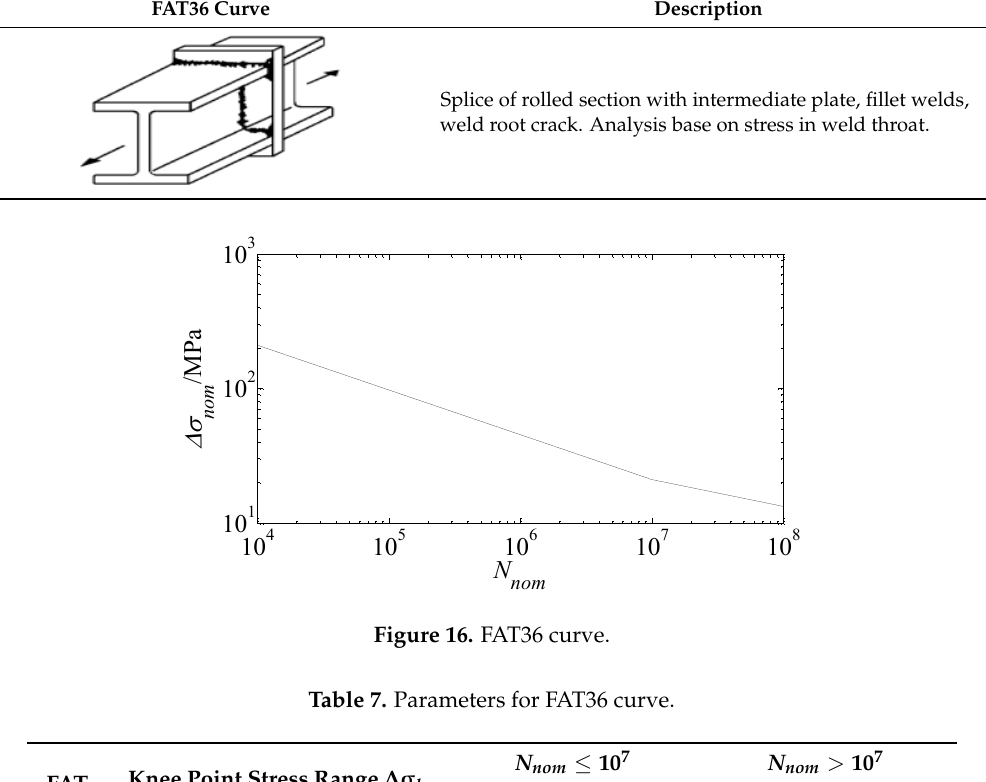
Figure 15. Global FE model. Table 6. Description of FAT36 curve.